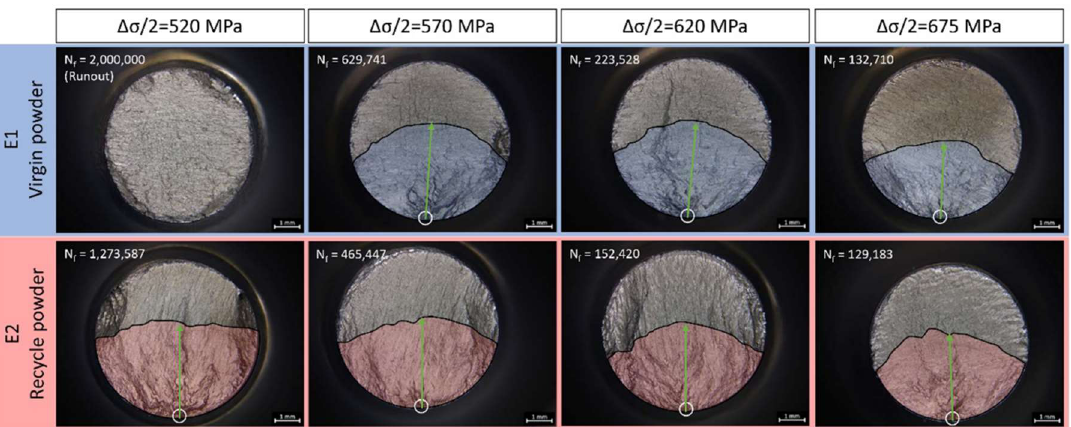
Figure 10. Fracture surface from optical micrographs (amplitude stress is 520 MPa, 570 MPa, 620 MPa, 675 MPa from left to right. Upper row is E1 and lower row is E2 specimens. The runout specimen was broken by the tensile test machine).